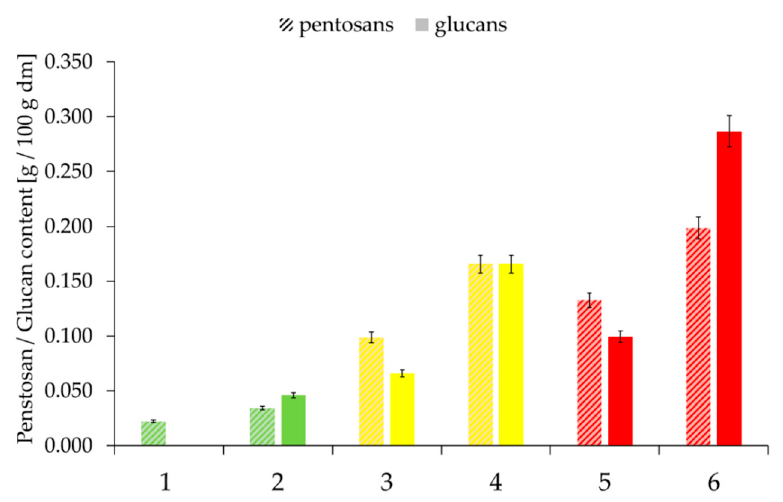
Figure 6. Microscopic images of protein distribution and coating (red spots and aura) of the starch granules (black balls) surfaces of the selected samples, depending on “good” to “medium” to “poor” baking quality and the corresponding falling number (FN) within the individual baking quality classes (here: first samples were always assigned the lower FN and second samples the higher FN). Sample description: see Table 1; bar = 15 µm.